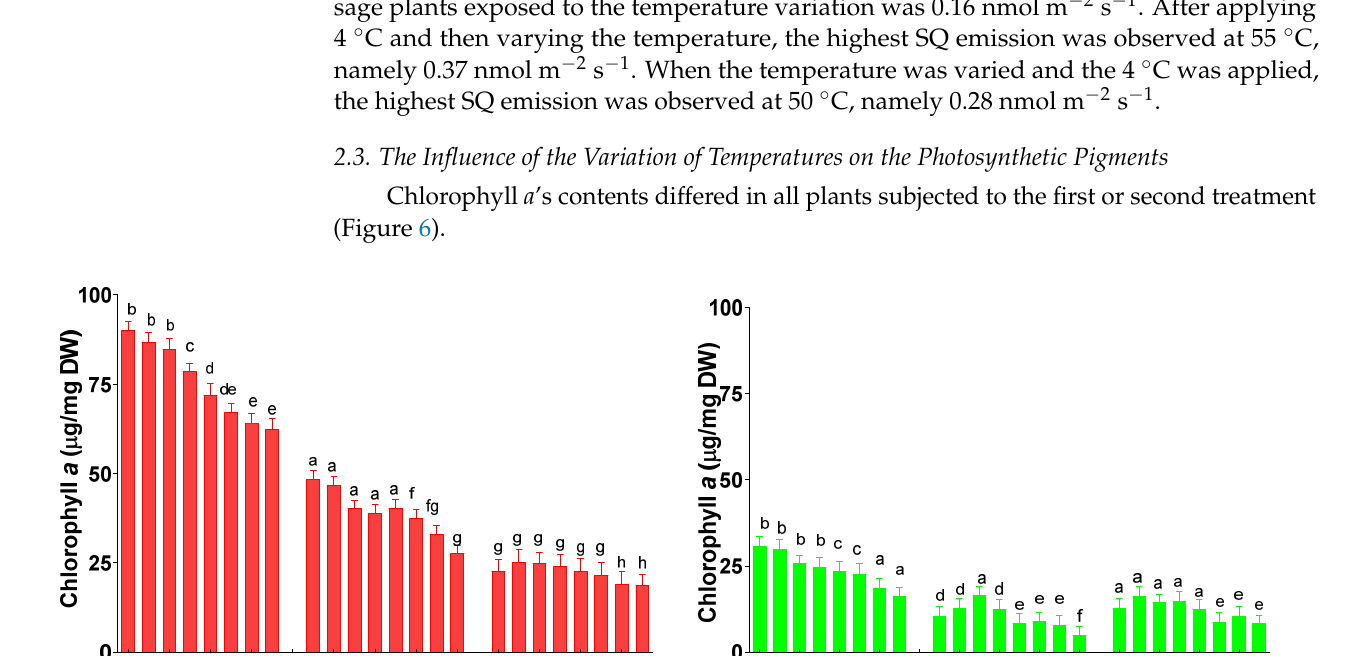
Figure 5. The sesquiterpenes emission rate from basil plants ( a ) and sage plants ( b ); plants were subjected to different temperatures.